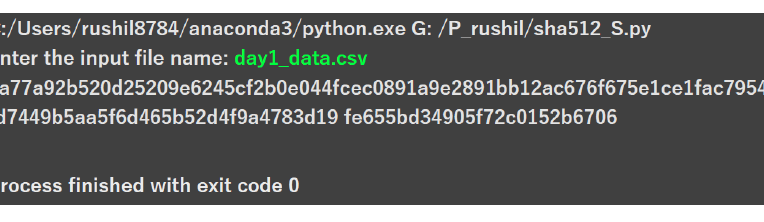
Figure 7. Sender’s data hash value